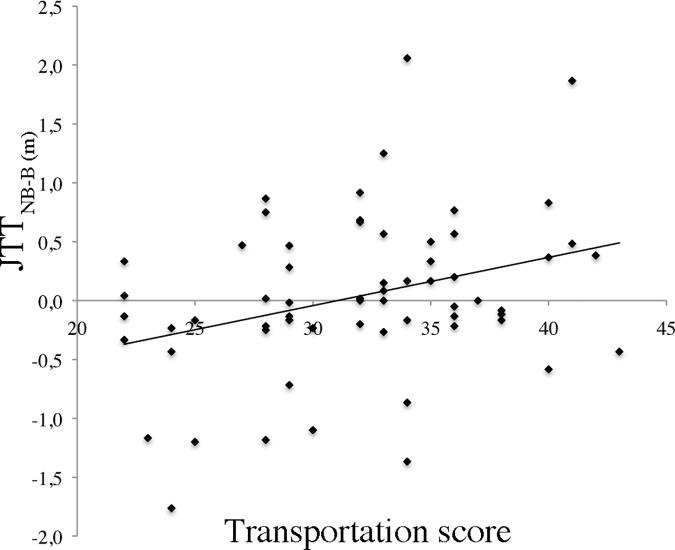
Significant correlation between the JTTNB-B index and the questionnaire transportation score.